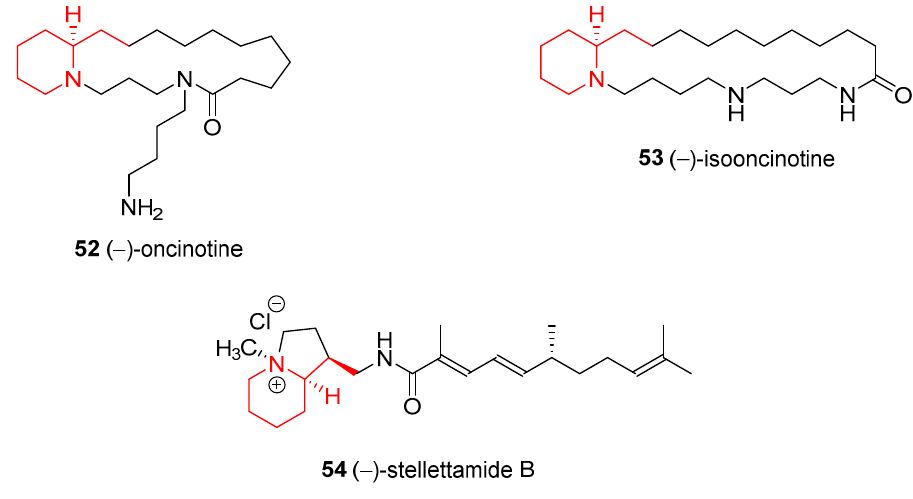
Figure 2. Structures of the alkaloids ( − )-oncinotine, ( − )-isooncinotine, and ( − )-stellettamide B.